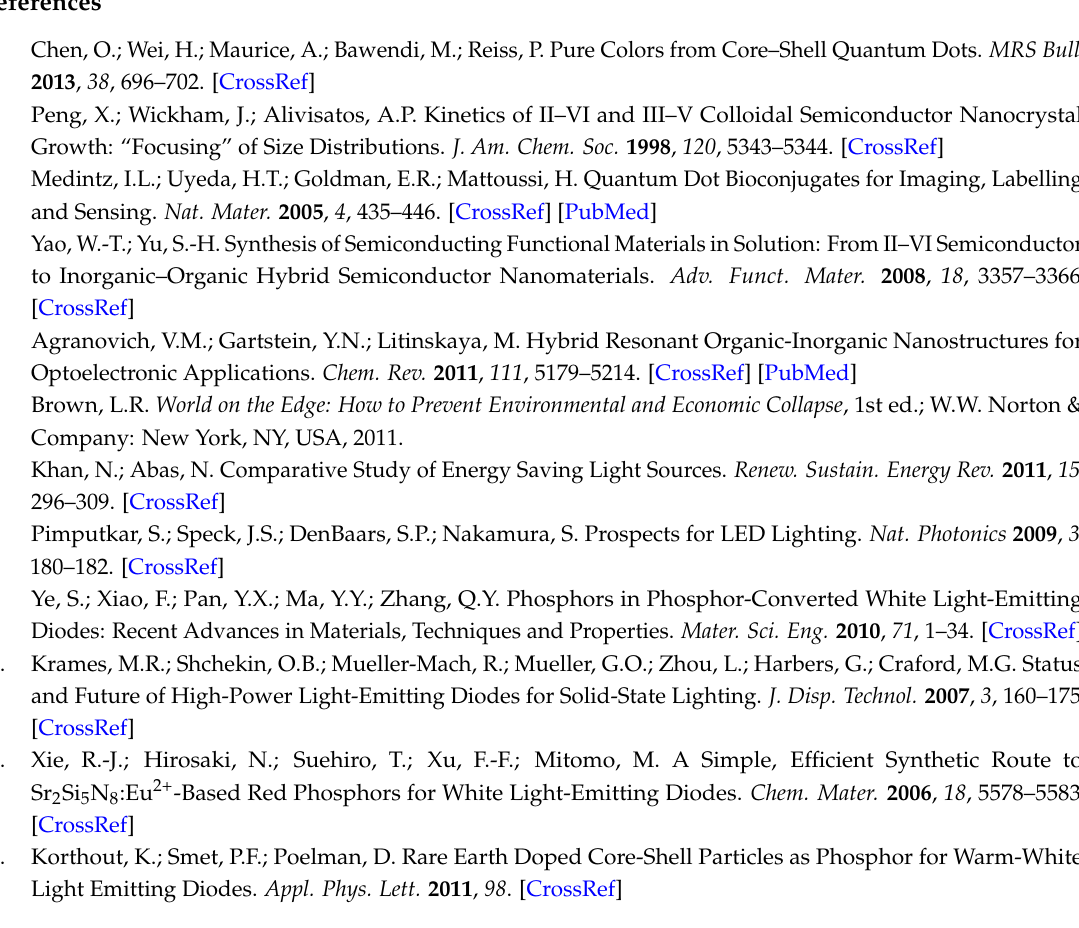
Figure S1: deconvoluted PL spectra of CdSe/CdS NCs, Figure S2: absorption spectrum of TGA, Figure S3: excitation spectra of CdSe/CdS NCs in the NC conjugate, Figure S4: CIE 1931 color space diagram for mixtures of non-linked CdSe/CdS and Ga 2 O 3